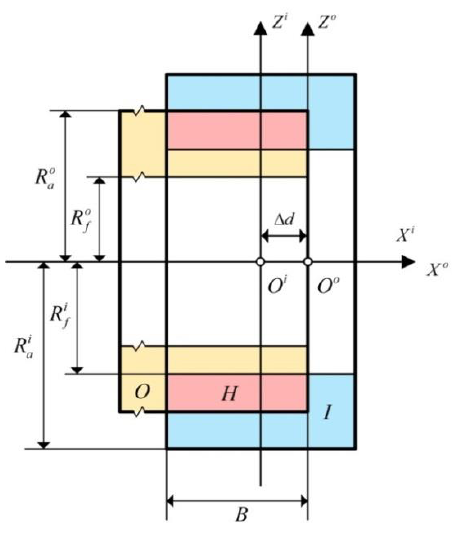
Figure 4. The meshing model of gear coupling without misalignment.